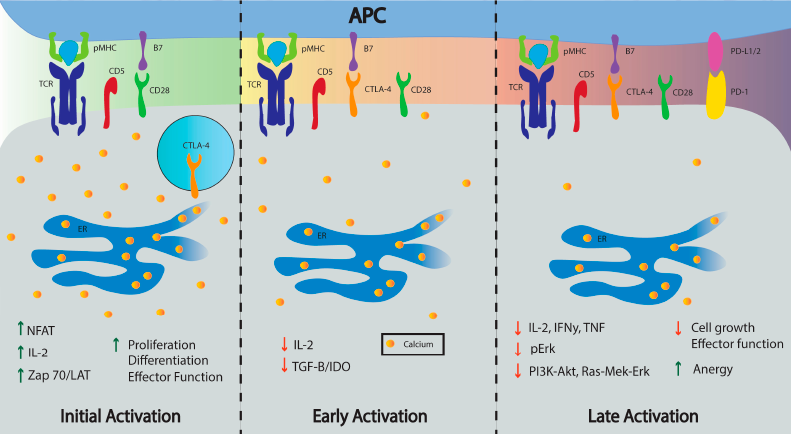
Figure 2. Inhibiting co-receptors modulate T cell activation by increasing (green arrows) or decreasing activity (red arrows). CD5 is present in naïve T cells and localizes to the TCR:pMHC complex during activation. Initial activation cascades signal for the release of CTLA-4 from vesicles to the cell surface while the transcription factor NFAT transcribes PD-1. CTLA-4 provides inhibitory signals during